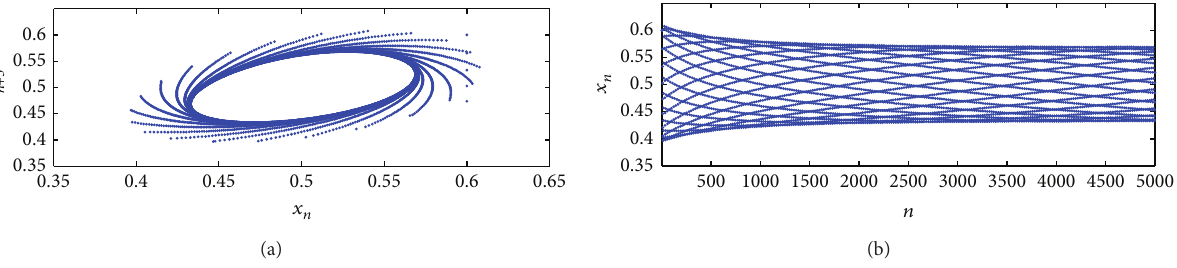
closed invariant curve bifurcating from 𝑥 ∗ is asymptotically stable. These are shown by Figures 3 and